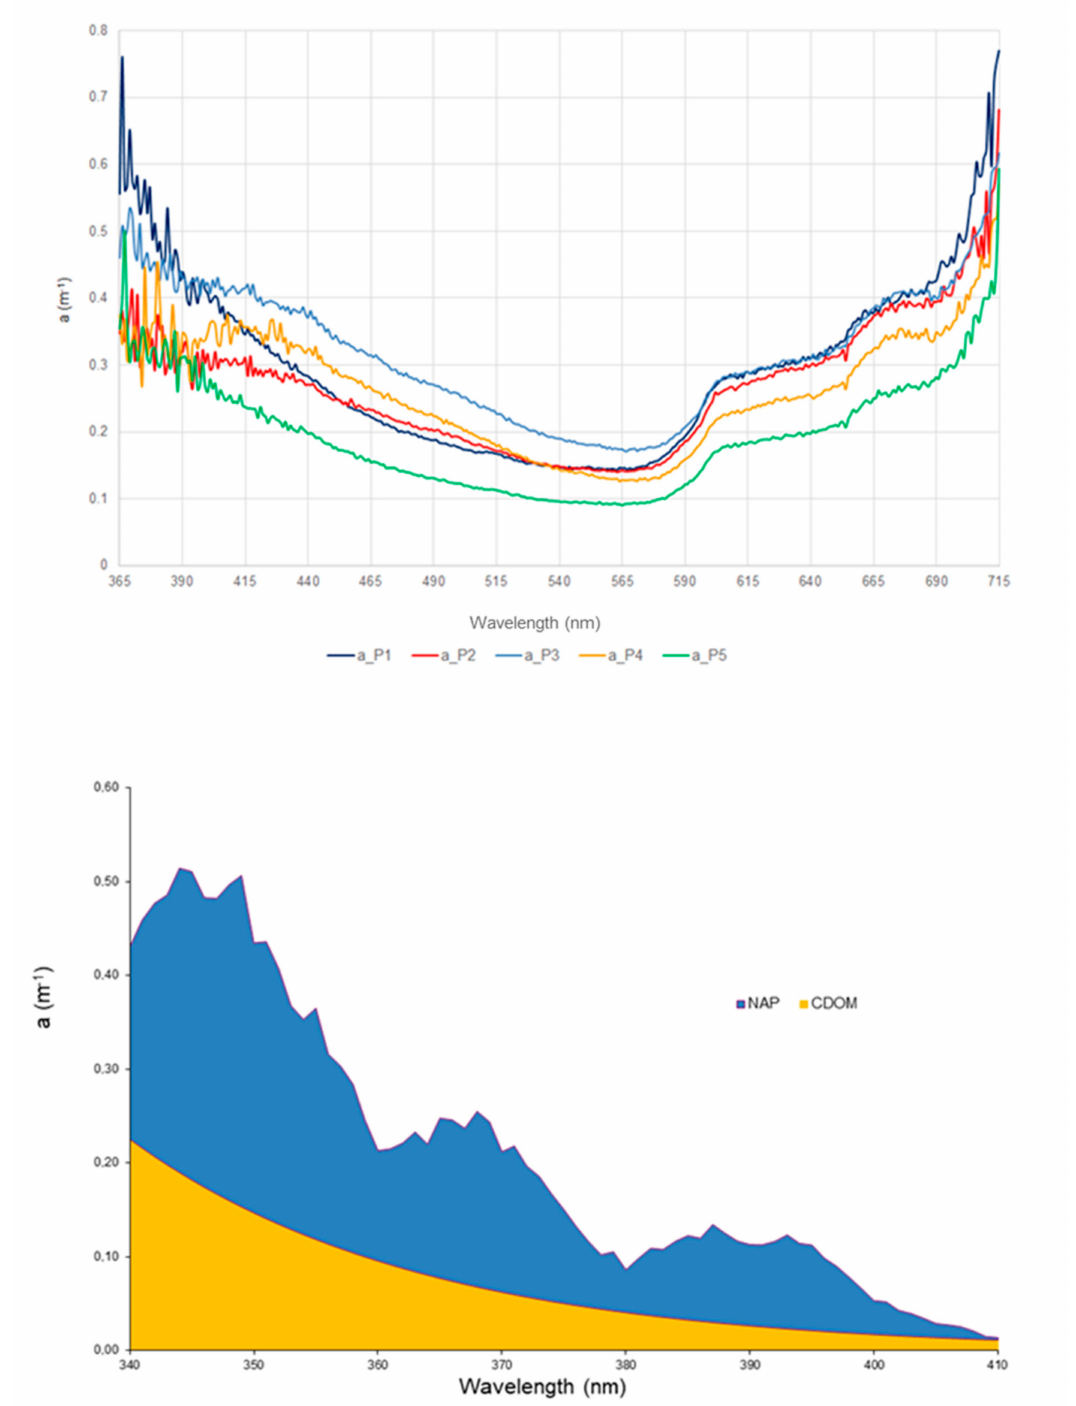
Figure 5. Water absorption coe ffi cients, a ( λ ), estimated from apparent optical properties measured on 2 April 2017. The study of the water absorption coe ffi cients allowed the determination of the colored dissolved organic matter ( CDOM ) absorption coe ffi cient, acdom ( λ ), and the non-algal particles (NAP) absorption coe ffi cient, anap( λ ). The anap ( λ ) shows that there is other matter which interacts with the rest of the water